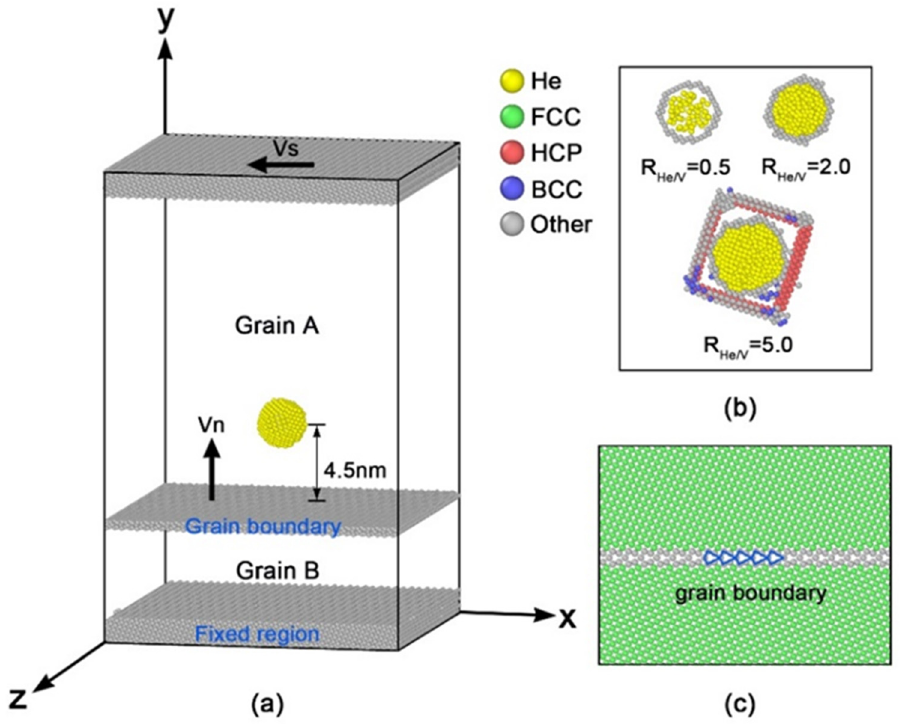
Figure 1. Shear simulation setup. ( a ) Initial configuration of the simulation system; ( b ) Representative He bubbles with different R He/V ; ( c ) GB structure.